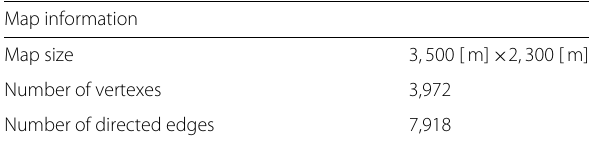
Table 1 Information of the map of Nagoya